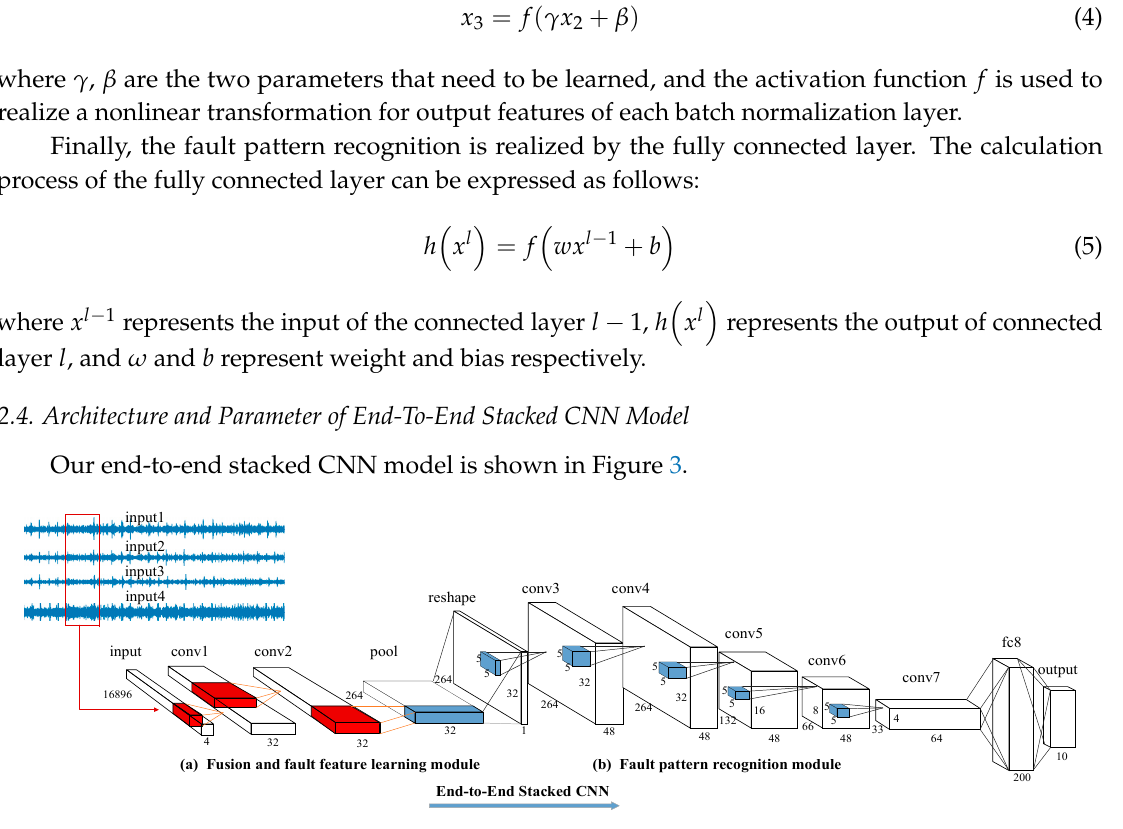
Figure 3. Architecture of the end-to-end stacked CNN. It consists of two parts: fusion and fault feature learning module ( a ) and fault pattern recognition module ( b ).